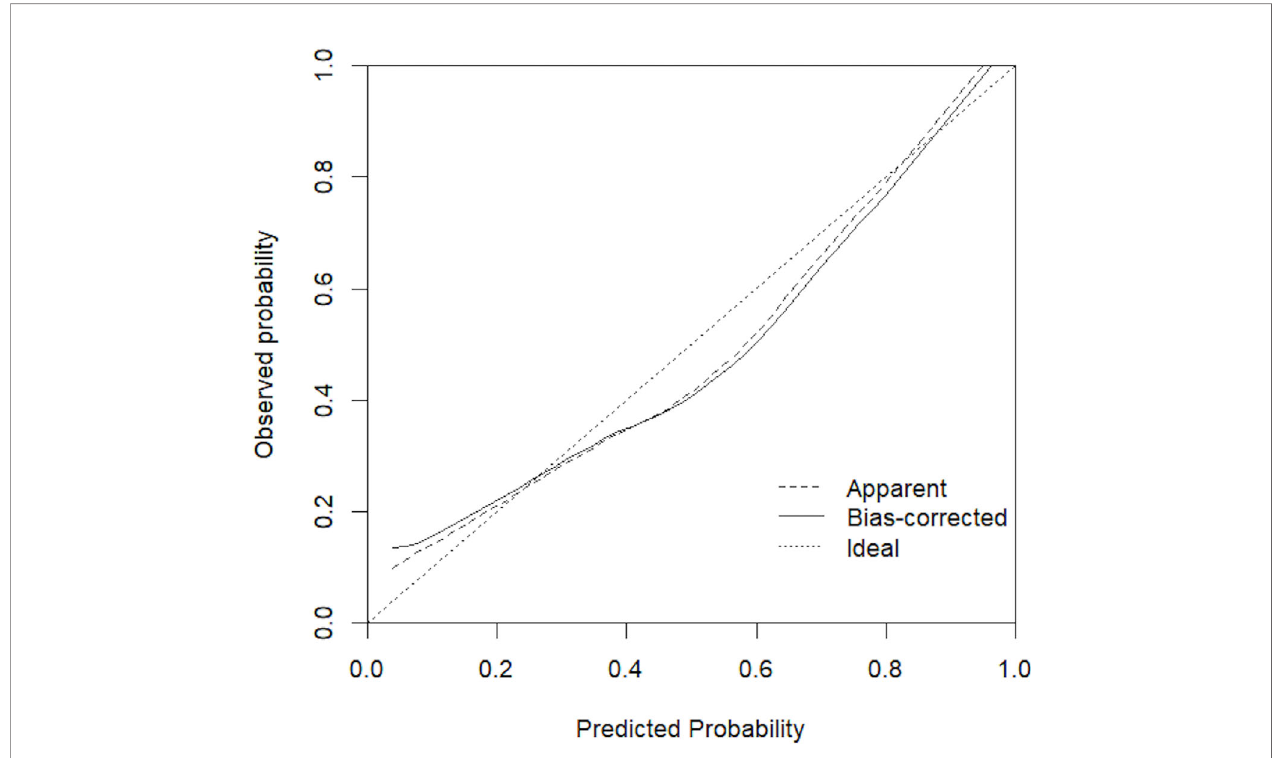
FIGURE 4 | Calibration curve for the nomogram